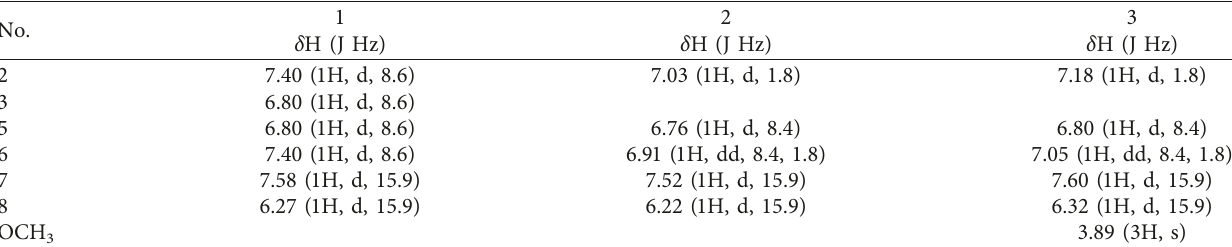
Table 1: 1 H-NMR (500 MHz, CD